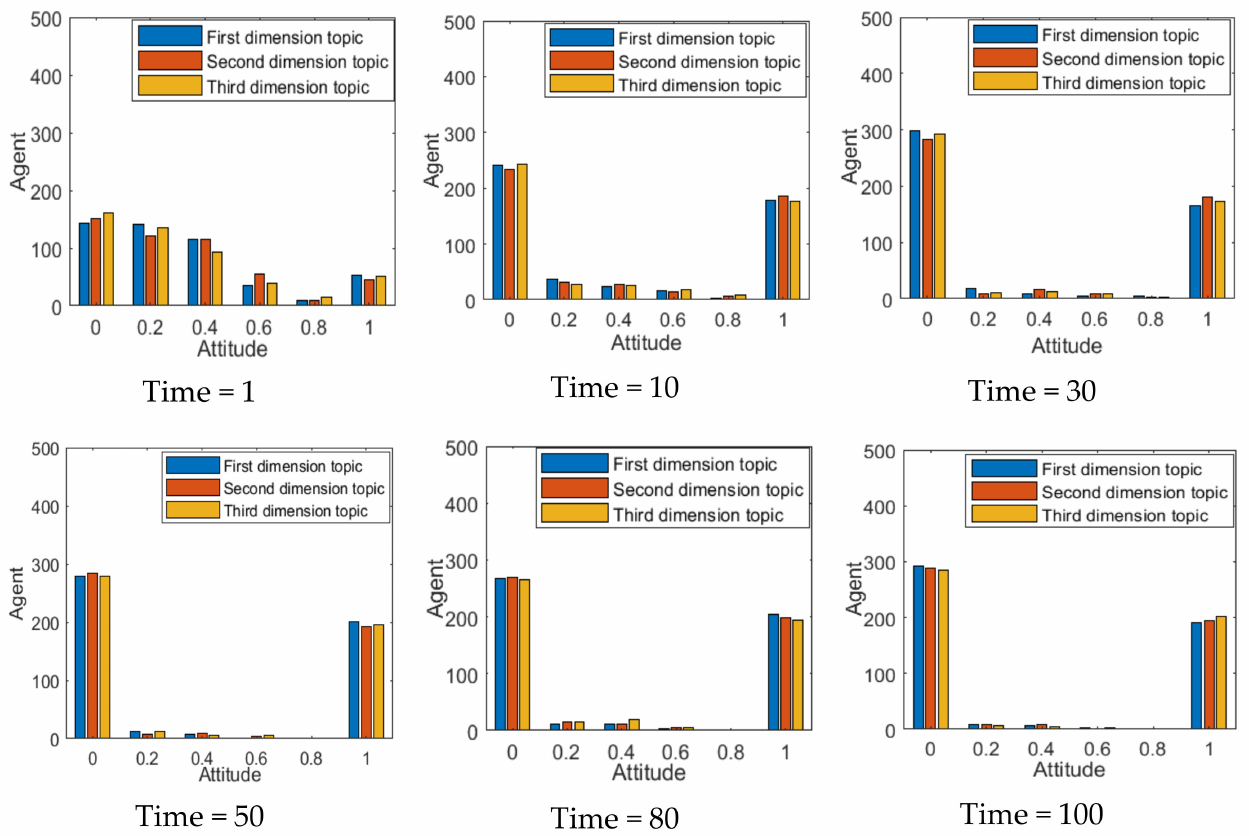
Figure 10. Histogram of group attitude distribution under different interaction